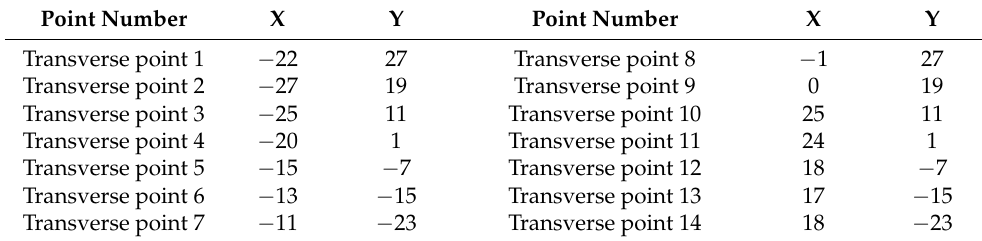
Table 4. The coordinates of grain 1 (G1) boundary information points (transverse point). Point Number